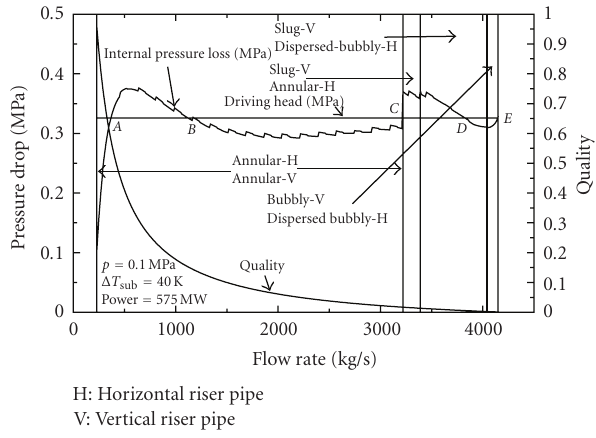
Figure 2: Typical flow pattern transition instability in boiling natural circulation